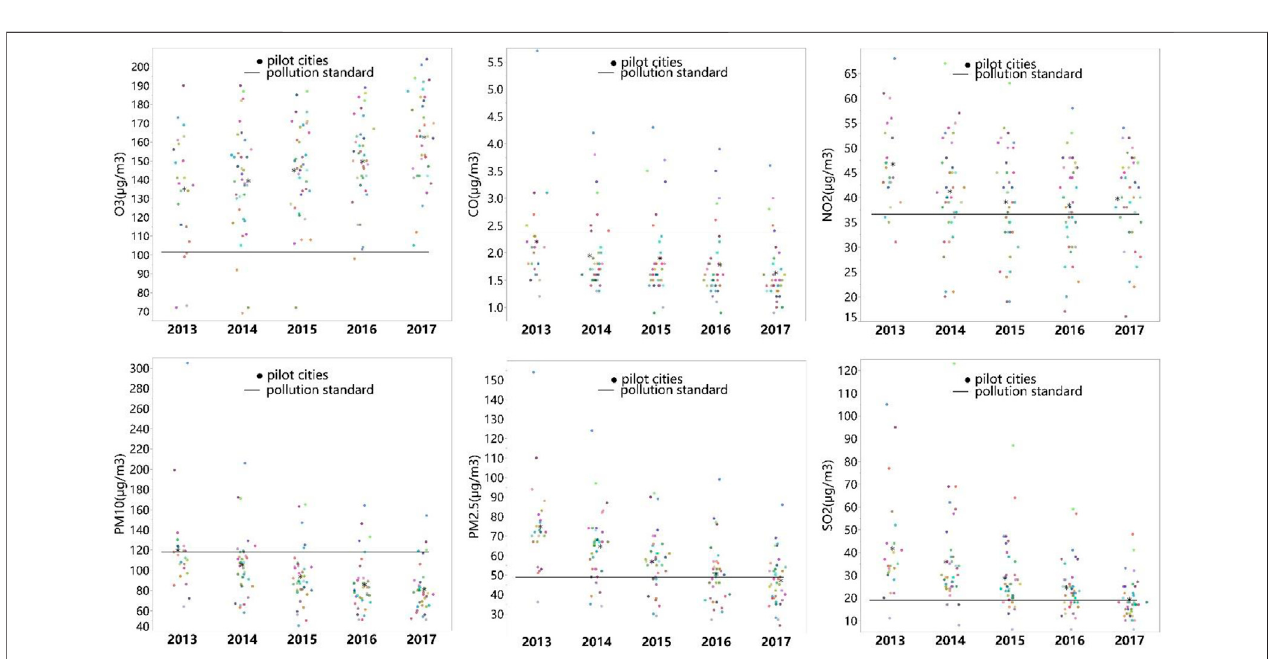
FIGURE 2 | Air pollutant distribution of the pilot